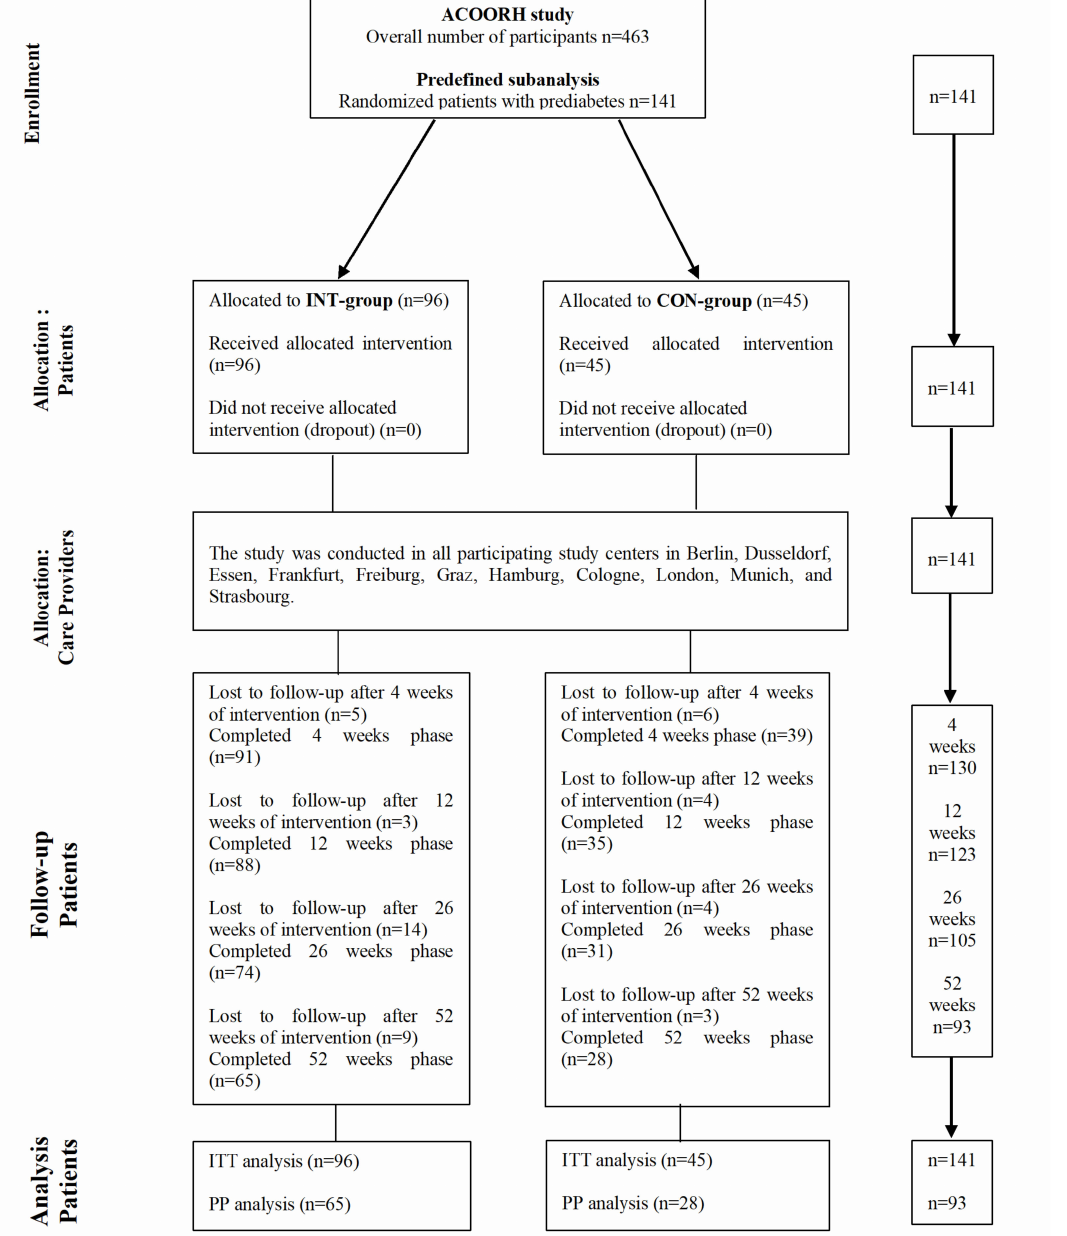
Figure 1. Flow diagram. ACOORH study, Almased Concept against Overweight and Obesity and Related Health Risk study; INT, intervention; CON, control; ITT, intention-to-treat; PP,